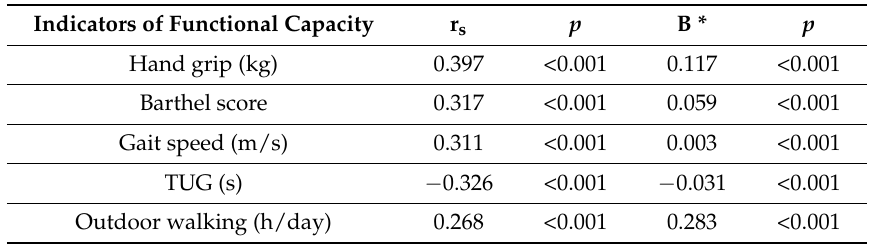
Table 2. Relationship between ICW/LM ratio (in mL/kg) and indicators of muscle strength and functional capacity (continuous variables).